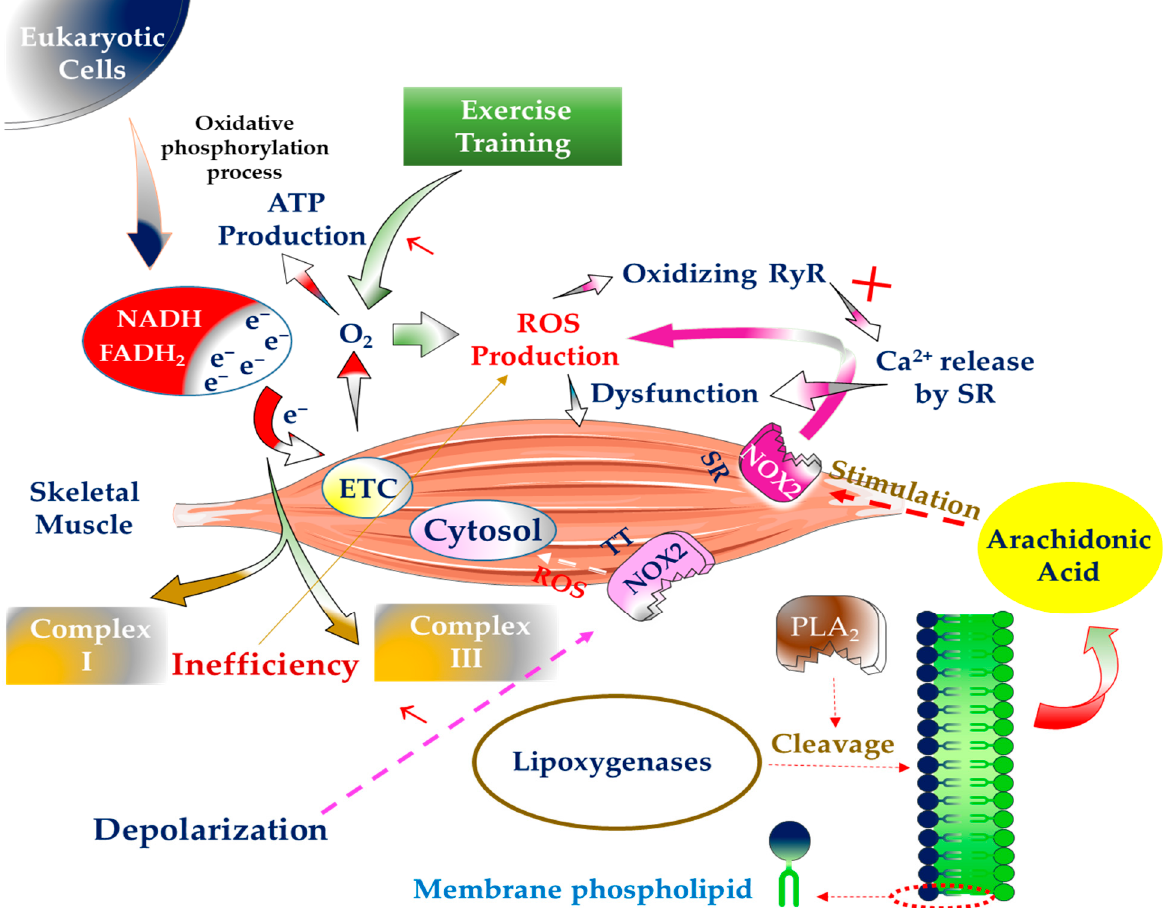
Figure 1. ROS generation sources in skeletal muscle. Reactive oxygen species (ROS), nicotinamide adenine dinucleotide (NADH), flavin adenine dinucleotide (FADH 2 ), electron transfer chain (ETC), ryanodine receptor (RyR), sarcoplasmic reticulum (SR), nicotinamide adenine dinucleotide phosphate (NADPH)-oxidase (NOX), transverse tubes (TT), phospholipases A 2 (PLA 2 ).